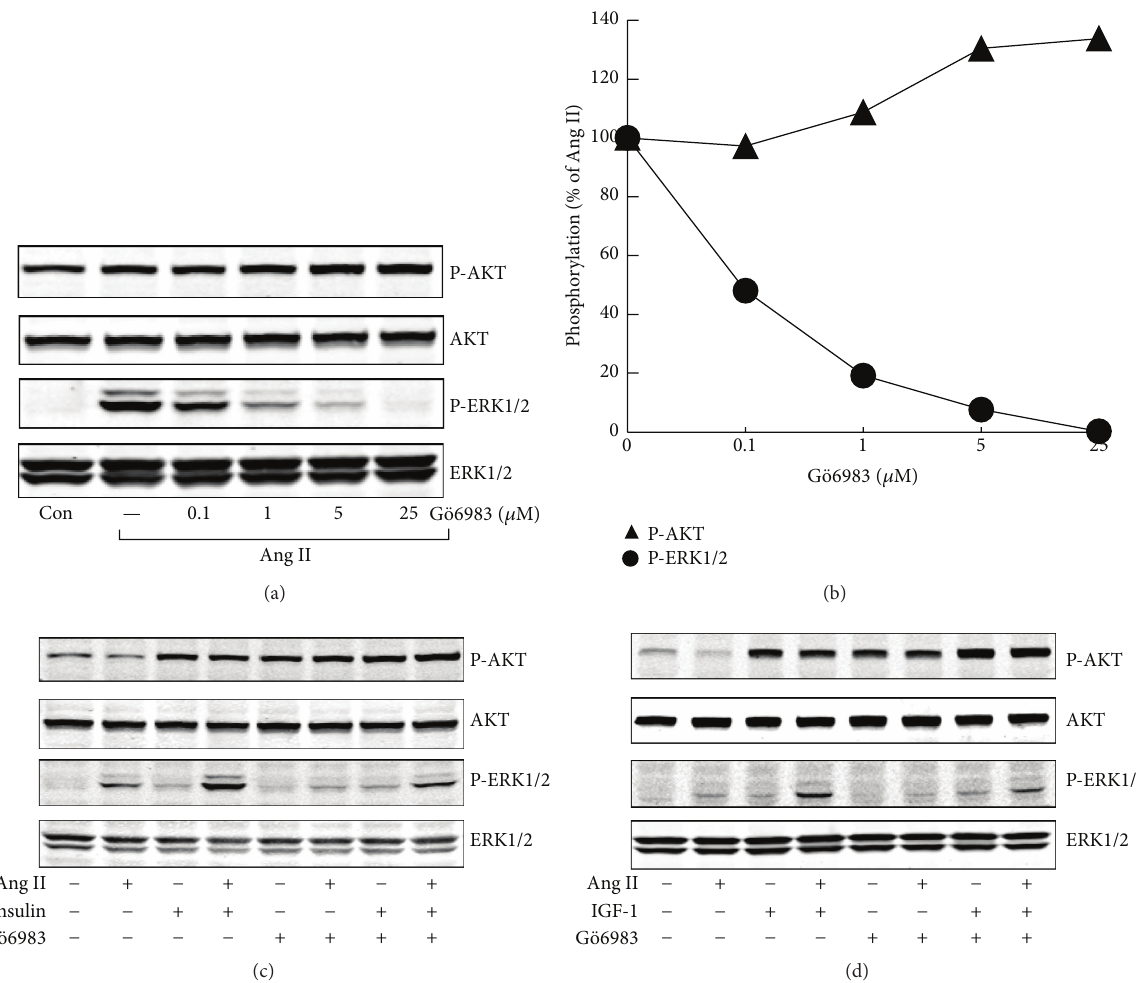
Figure 5: Involvement of PKC in agonists-stimulated phospho-ERK1/2 and phospho-AKT in H295R cells. (a) Effects of G¨o6983, a PKC inhibitor, on Ang II-induced ERK1/2 and AKT phosphorylation. H295R cells were treated with increasing concentrations of G¨o6983 for 30 min and then stimulated with Ang II (100nM) for 5min. (b) Quantitative determination of the effects of G¨o6983 on Ang II-induced ERK1/2 and AKT phosphorylation from panels (a). (c and d) After incubation with G¨o6983 (5 𝜇 M) for 30 min, H295R cells were pretreated with Ang for another 30min and then stimulated with insulin/IGF-1 for 5 min. (c) Insulin (100nM); (d) IGF-1